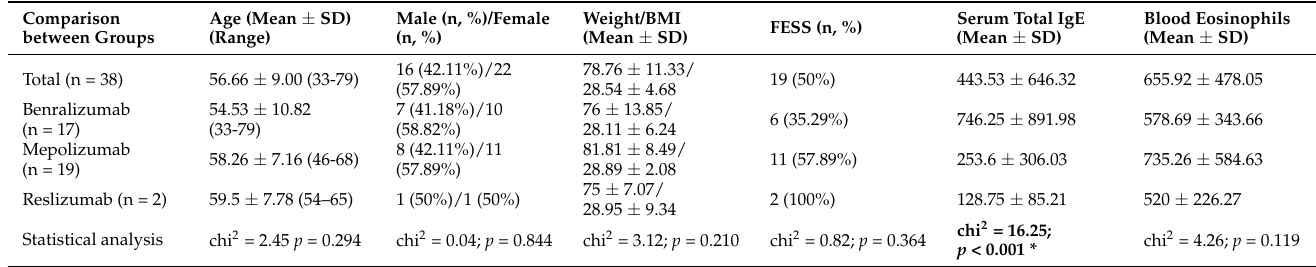
Table 1. Description of the sample. Bold and asterisk if statistically significant.